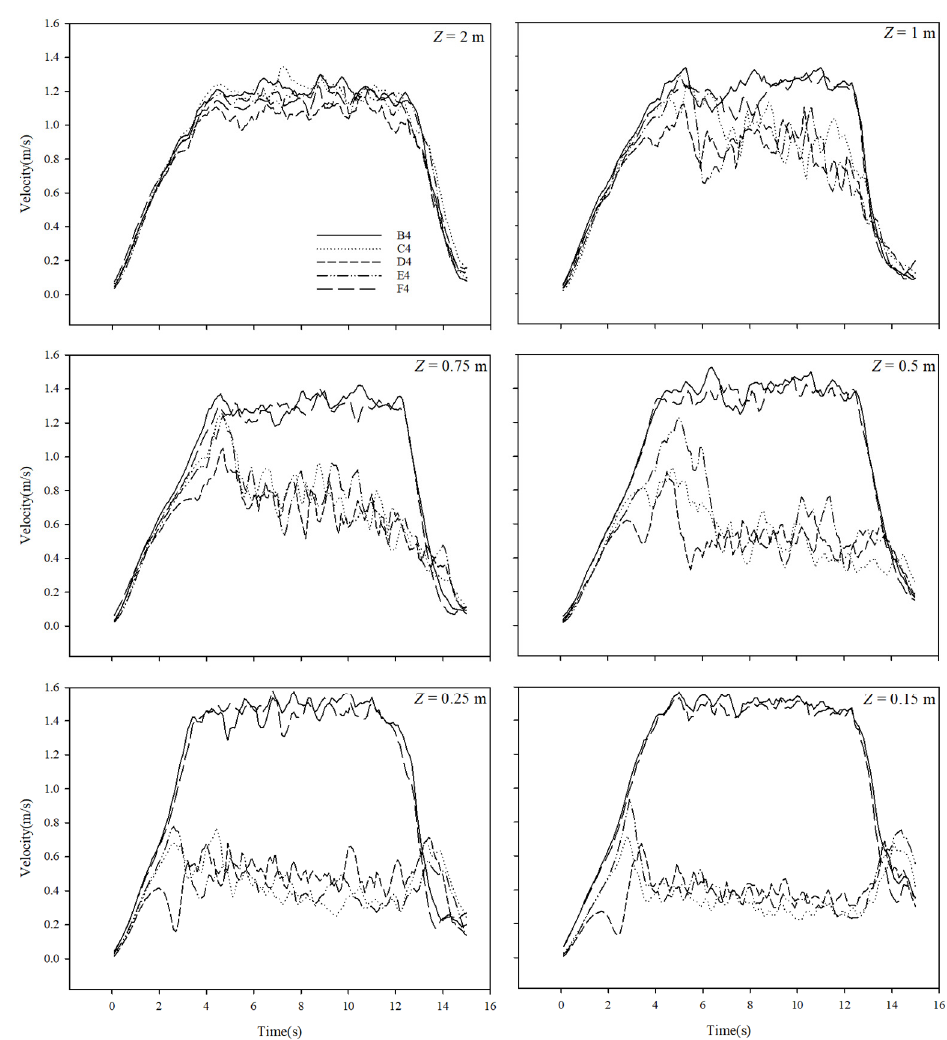
Figure 3. Velocity measurements at different locations (average of five measurements taken at the 4 th height